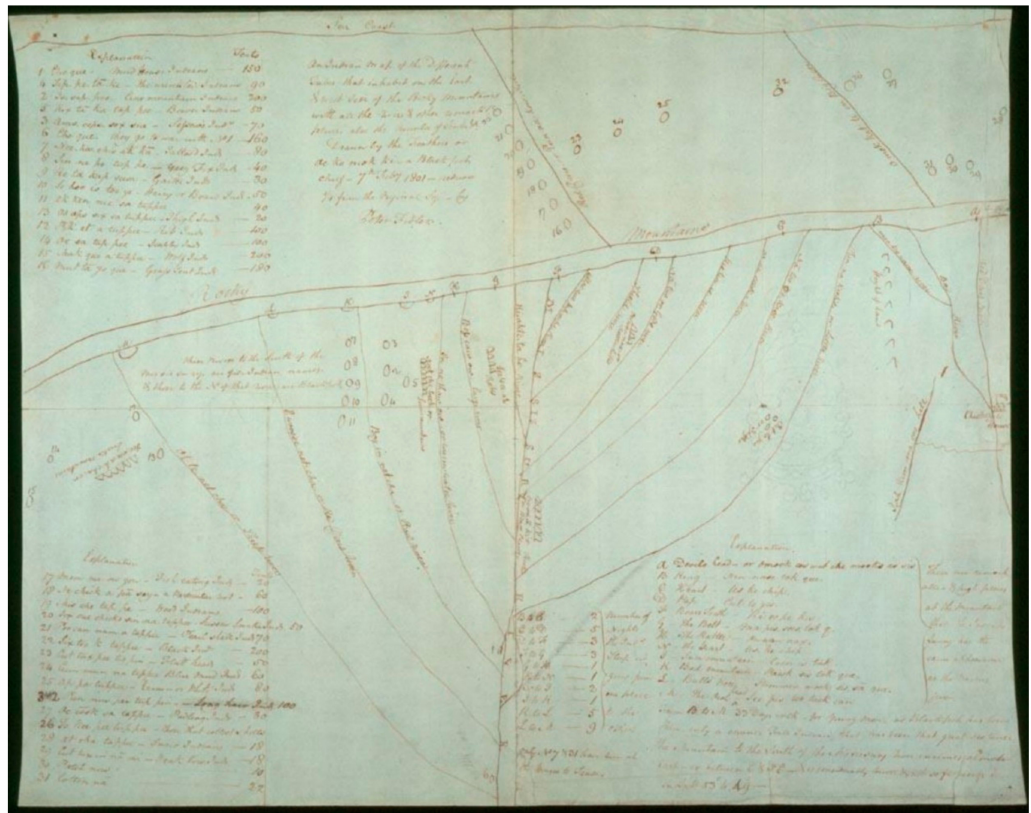
Figure 2. Map by Ac ko mok ki of the drainage network from the Missouri River to the Rocky Mountains, with annotations by Peter Fidler. Downloaded from the Hudson’s Bay Company